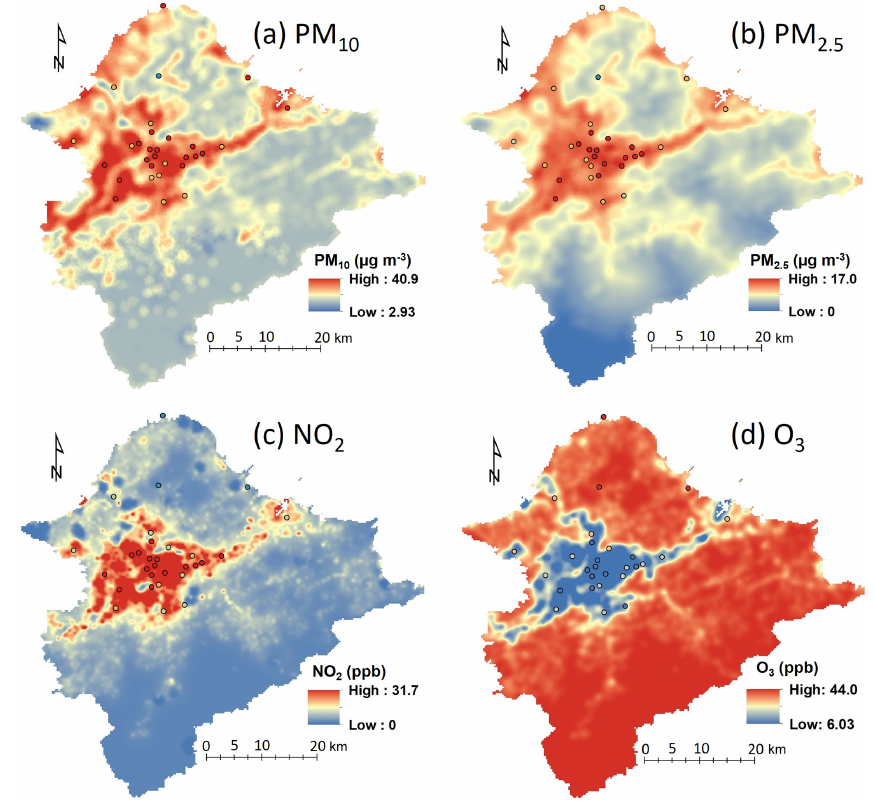
Figure 4. The spatial distribution of ambient air pollutant concentrations derived from established LUR models. (a) PM 10 , (b) PM 2 . 5 , (c) NO 2 and (d) O 3 . The colored circles represent the observations from